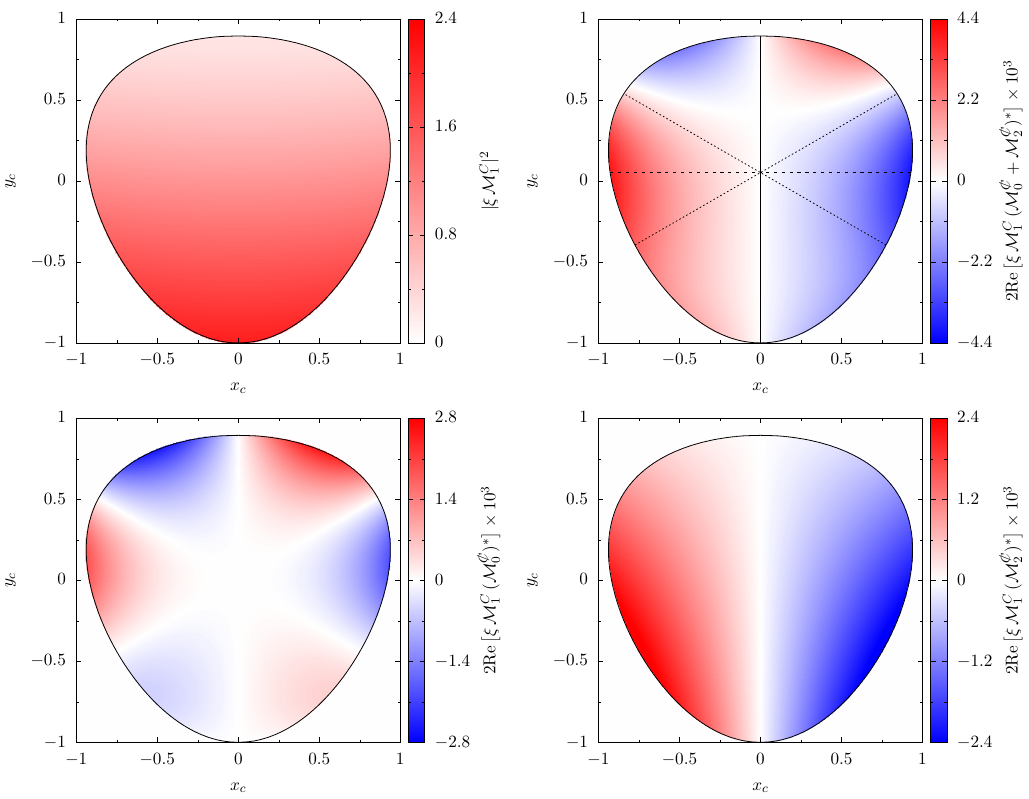
Figure 5 . Decomposition of the Dalitz-plot distribution for η → π + π − π 0 as given in eq. (2.41) for the central fit result. The normalization is chosen such that | ξ M C | 2 (top left) is one in the 1 center. Note the individual scales of each contribution. The interferences of M C with M 6 C (bottom 1 0 left) and M 6 C (bottom right) give rise to mirror symmetry breaking in the Dalitz plot. The total 2 C -violating contributions to the full Dalitz plot is shown in the upper right, including the symmetry axes to define asymmetry parameters. The left-right asymmetry A compares the population of LR the left and right halves divided by the line t = u (solid vertical line), A the quadrants divided c c Q by t = u and s = r (solid vertical and dashed horizontal lines), and A the sextants divided c c c c S by t = u , s = t , and s = u (solid vertical and dotted diagonal lines). The most significant c c c c c c impacts of the C -violating amplitudes are located in the vicinity of the kinematic